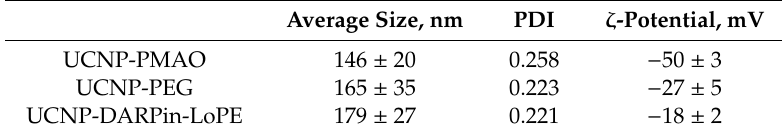
Table 1. The hydrodynamic diameter and zeta potential of UCNP and